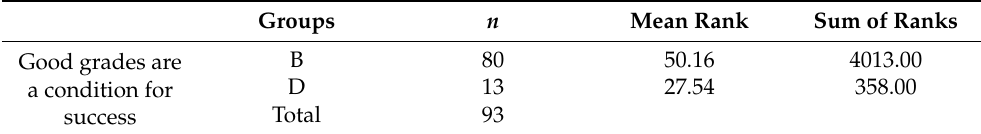
Table 2. Association of good academic grades and PCE misuse.